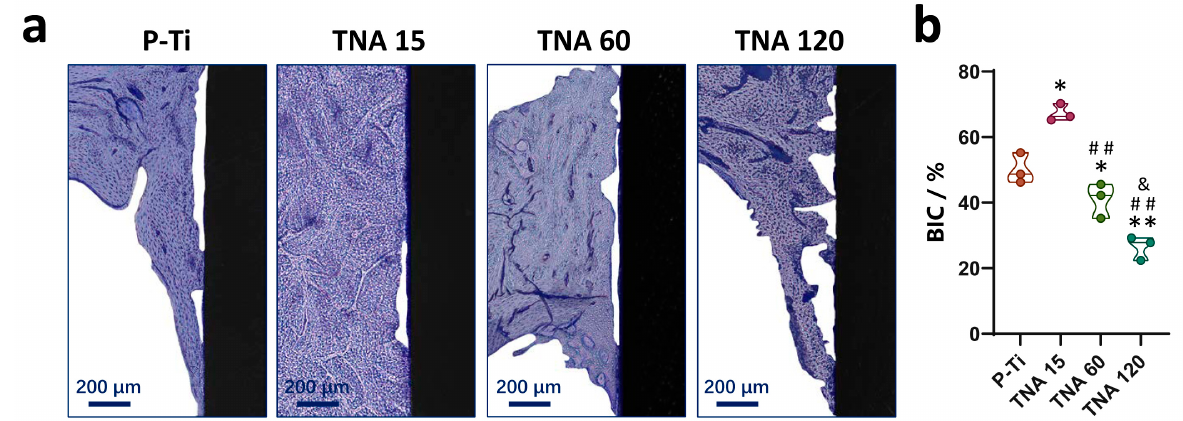
Figure 3. ( a ) Representative histological images of peri-implant bone tissue. ( b ) Quantitative results of BIC. * p < 0.05 compared to P-Ti, & p < 0.05 compared to TNA 60, ** p < 0.01 compared to P-Ti, ## p < 0.01 compared to TNA 15.